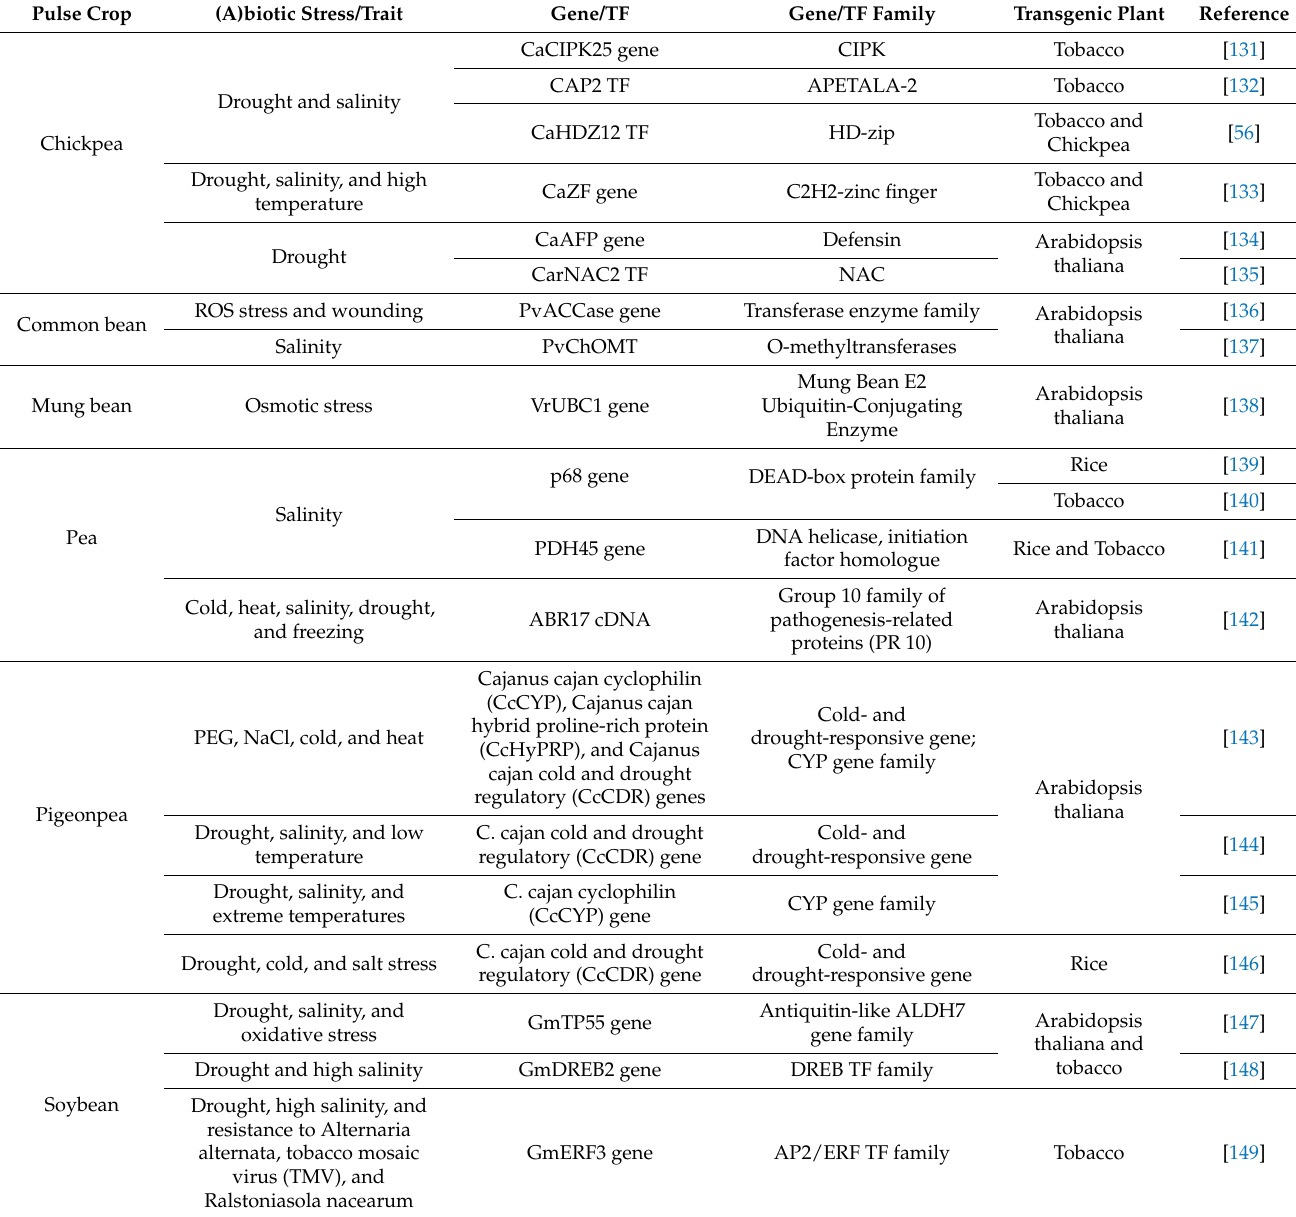
Table 4. Genes and transcription factors (TFs) from different pulse crops overexpressed to generate improved traits or abiotic-stress-tolerant transgenic